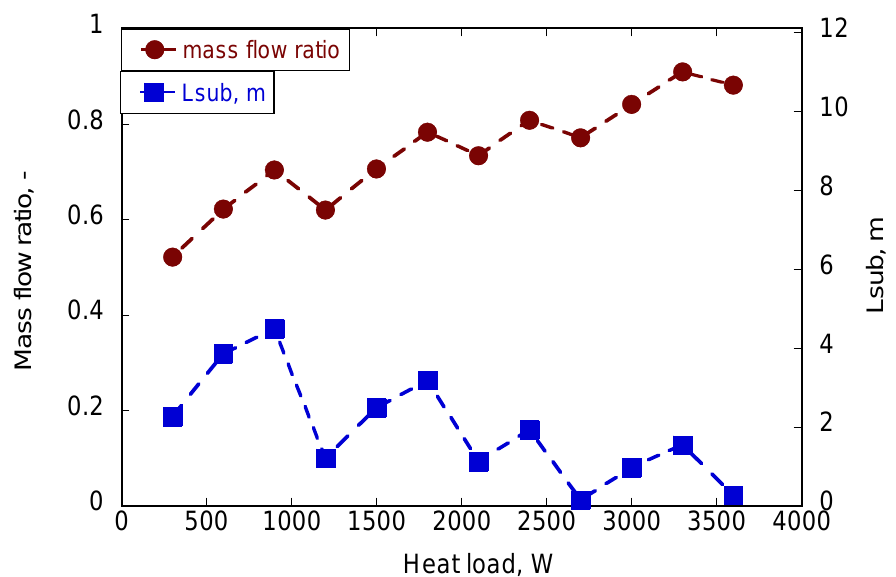
Figure 6. Calculation results of mass flow ratio and subcooled region length under even heat loads conditions.